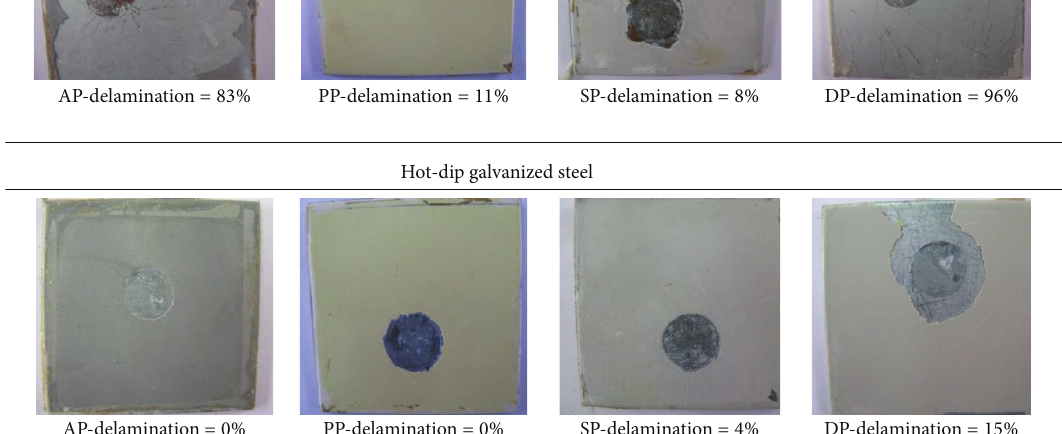
(i) The cathodic reaction corresponds to the reduction